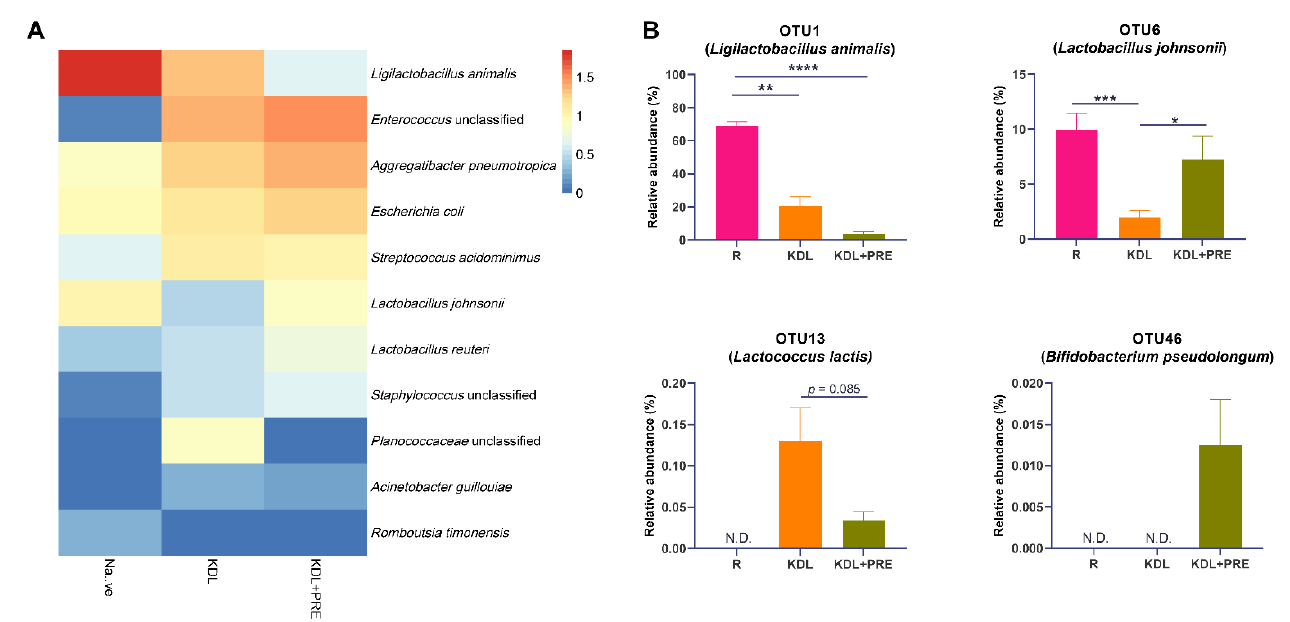
bacillus reuteri were the predominant species (Figure 6A). A detailed list of the detected